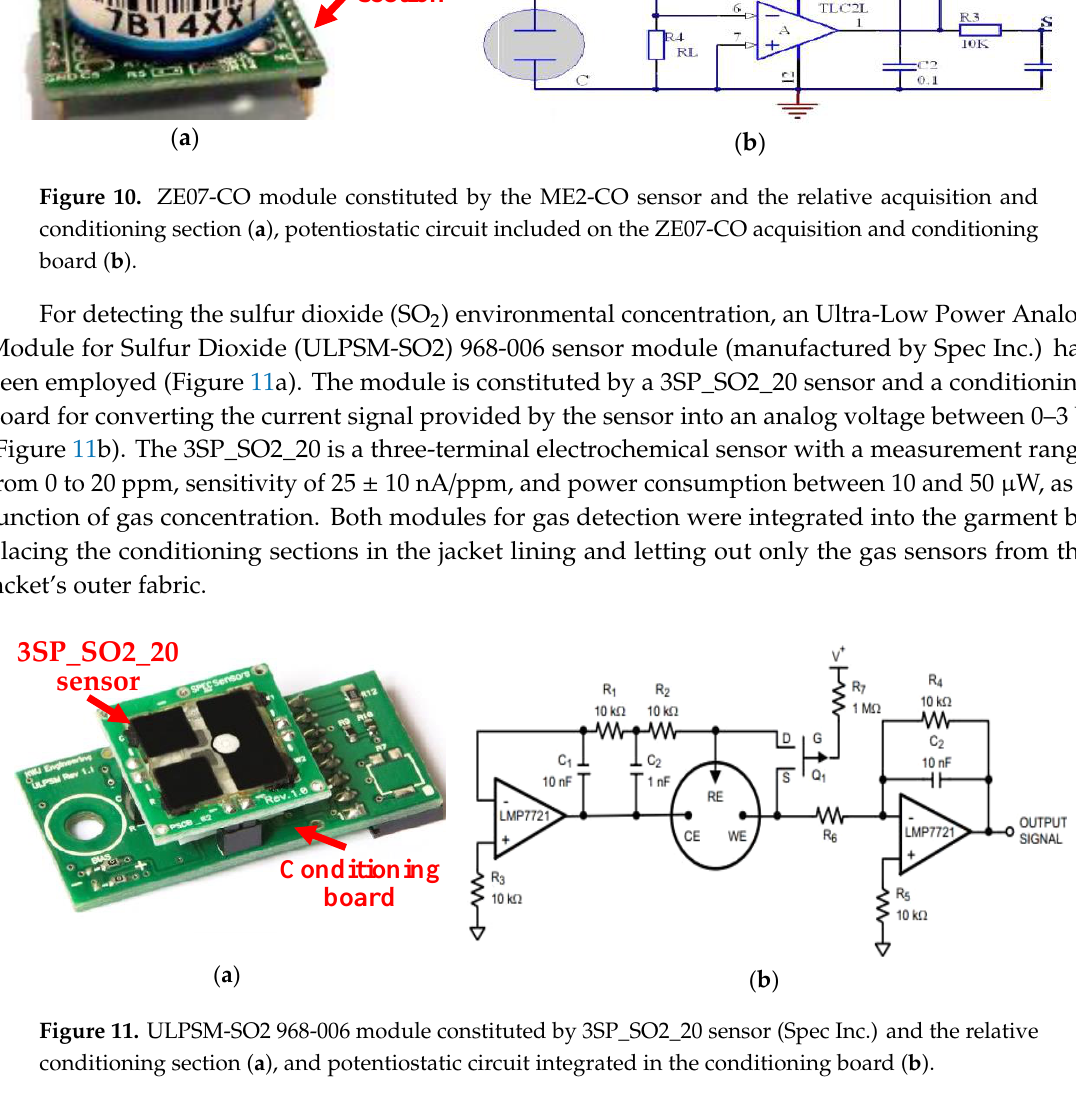
Figure 10. ZE07-CO module constituted by the ME2-CO sensor and the relative acquisition and conditioning section ( a ), potentiostatic circuit included on the ZE07-CO acquisition and conditioning board ( b ).